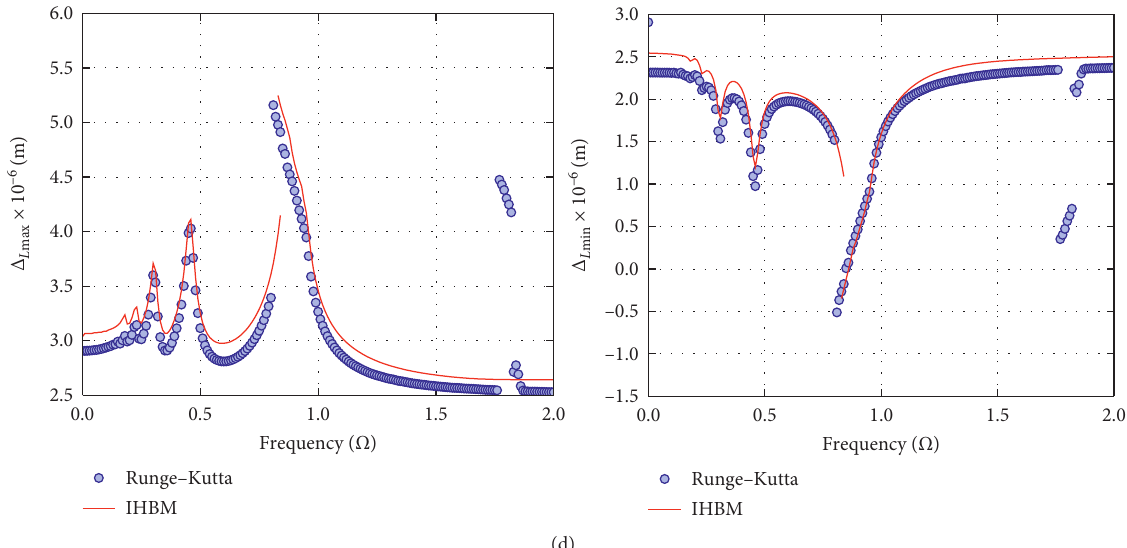
Figure 4: Amplitude frequency characteristic curve of the system under different models. (a) Constant backlash model under combined internal and external excitation, (b) constant backlash model under external excitation, (c) constant backlash model under internal excitation, and (d) dynamic backlash model under combined internal and external